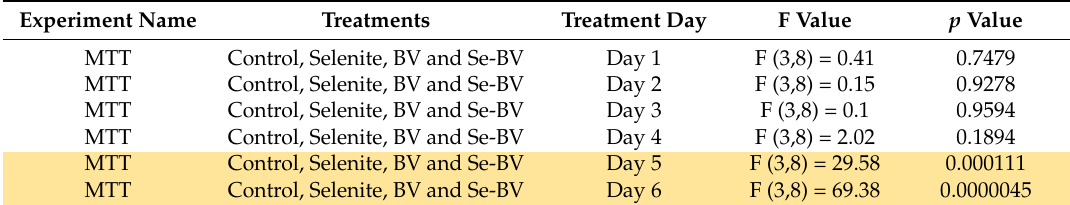
Table 5. ANOVA Results for Cell Metabolism with Se-BV Treatment for MDA-MB-468